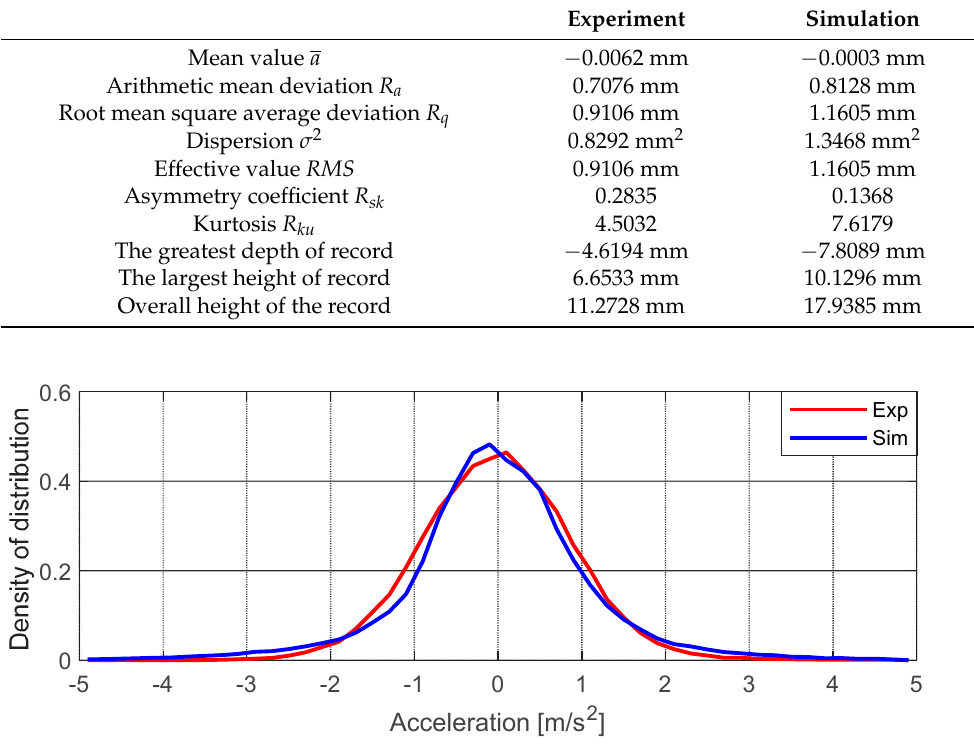
Figure 25. Density of probability distribution, acceleration on vehicle rear axle (RA).